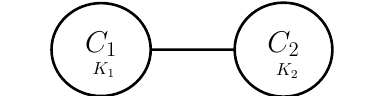
Fig. 3 Build a line between C 1 and C 2 when there is conflict.